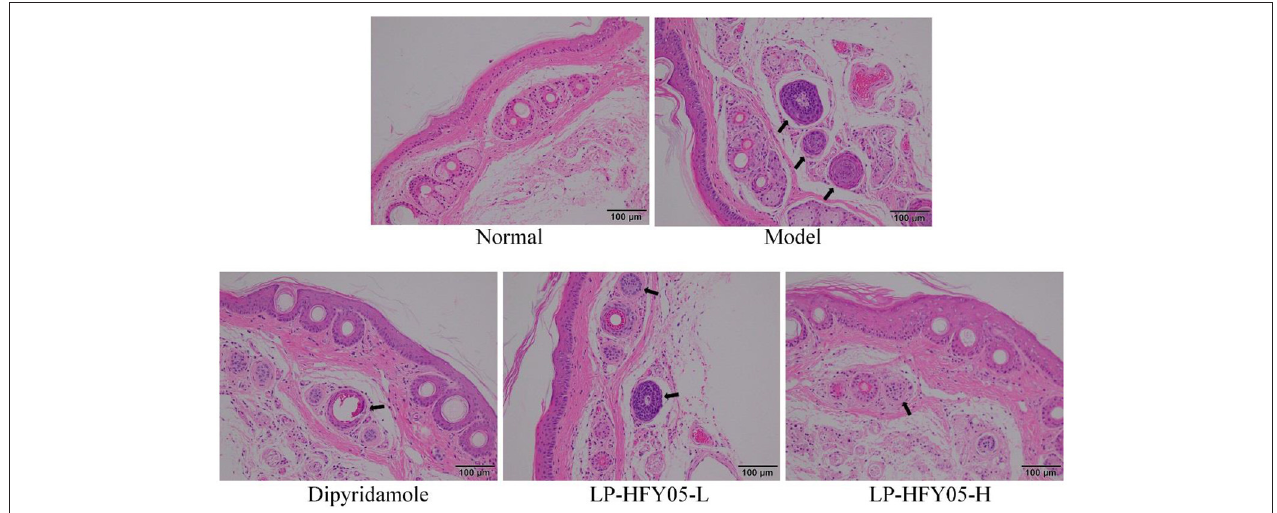
FIGURE 5 | Image of hematoxylin and eosin-stained renal tissue in mice. The arrow points to the thrombotic site.